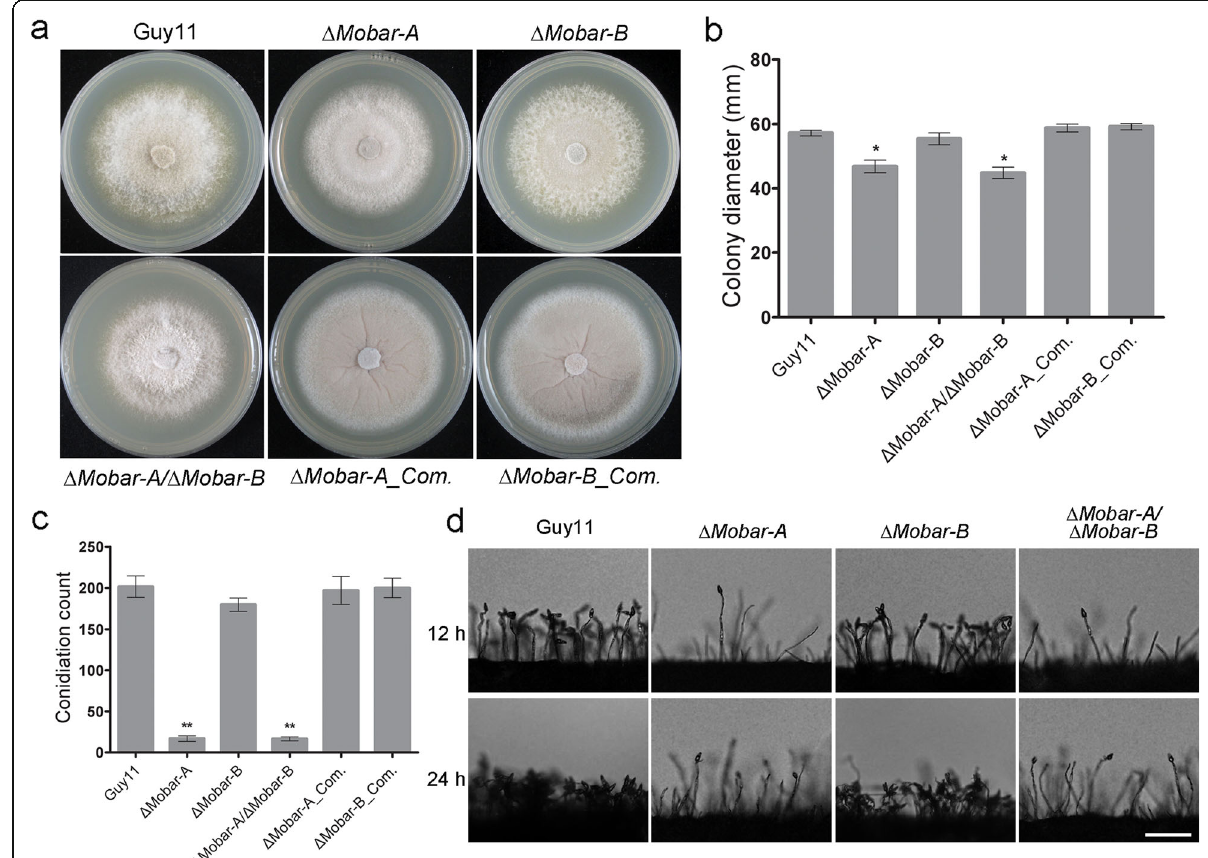
Fig. 4 MoBar-A plays an exclusive role in promoting hyphal growth and asexual reproduction in Magnaporthe oryzae. a Colony morphology of Δ Mobar-A , Δ Mobar-B , Δ Mobar-A / Δ Mobar-B, Δ Mobar-A _Com., Δ Mobar- B_Com. and the wild-type Guy11 strains on CM for 10 days. b Column diagram showing colony diameter of strains cultured on CM for 10 days. The error bars represent standard errors from at least three independent replicates (*, P < 0.05 by t-test). c Conidiation capacity of strains on rice bran medium. The error bars represent standard errors from at least three independent replicates (**, P < 0.01 by t-test). d Conidiophore development and spore formation attributes of strains cultured on rice bran medium for 10 days. Bar, 10 μ